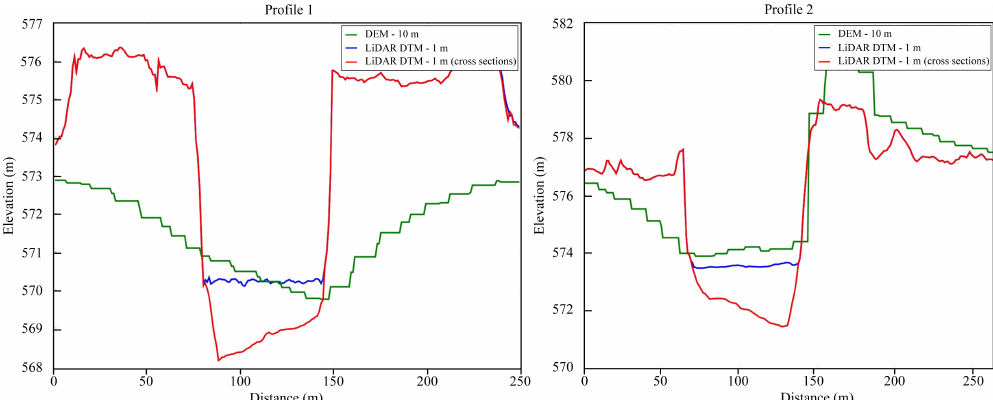
Fig. 2. Visualised differences between two exemplary cross-section representations in the municipal area of Innsbruck (province capital of Tyrol) to consider the water body of the Inn River for hydraulic model procedures. The demonstrated differences have a high influence on the model performance and are based on (i) the DTM of the Bundesamt f¨ur Eich- und Vermessungswesen (BEV) with a raster width of 10m (DTM – 10m), (ii) a LiDAR data based DTM with a raster width of 1m (LiDAR DTM – 1m), and (iii) a LiDAR data based DTM including ground truth survey data with a raster width of 1m (LiDAR DTM – 1m (cross section) (adapted and modified according to Adams et al., 2007).